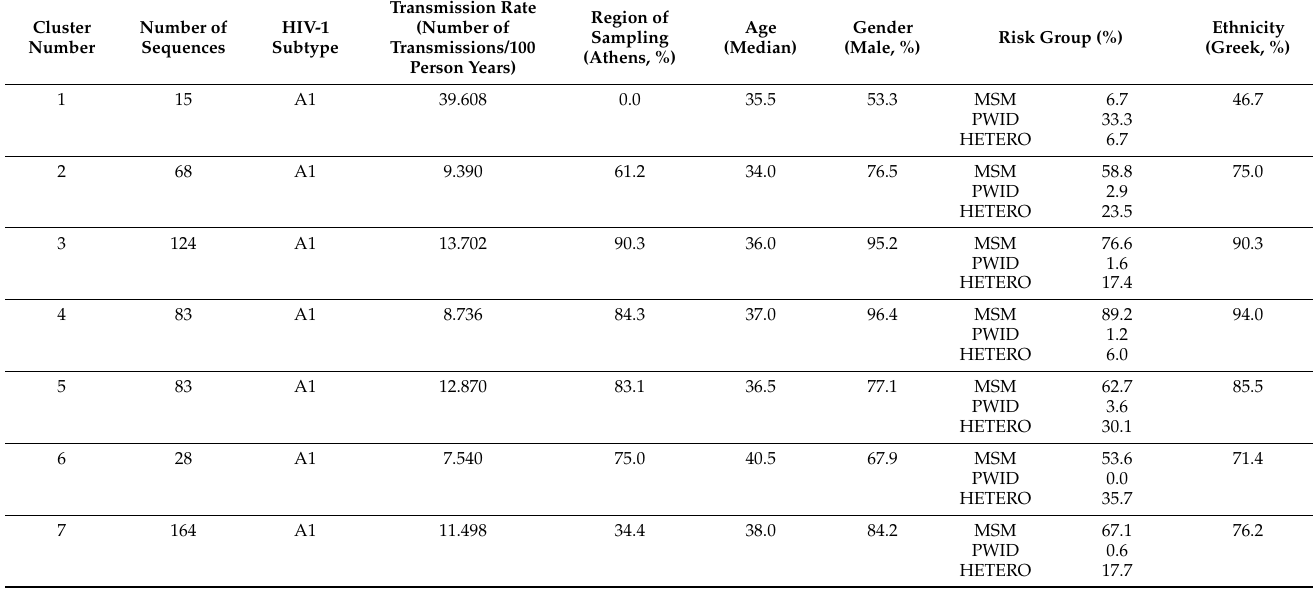
Table 3. Transmission rates and characteristics of the different molecular transmission clusters in